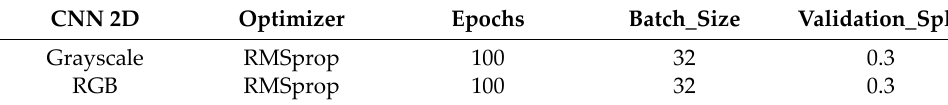
Figure 12. An illustration showing our image-based spam detection process. Table 8. Settings of CNN 2D model. Table 8. Settings of CNN 2D model.